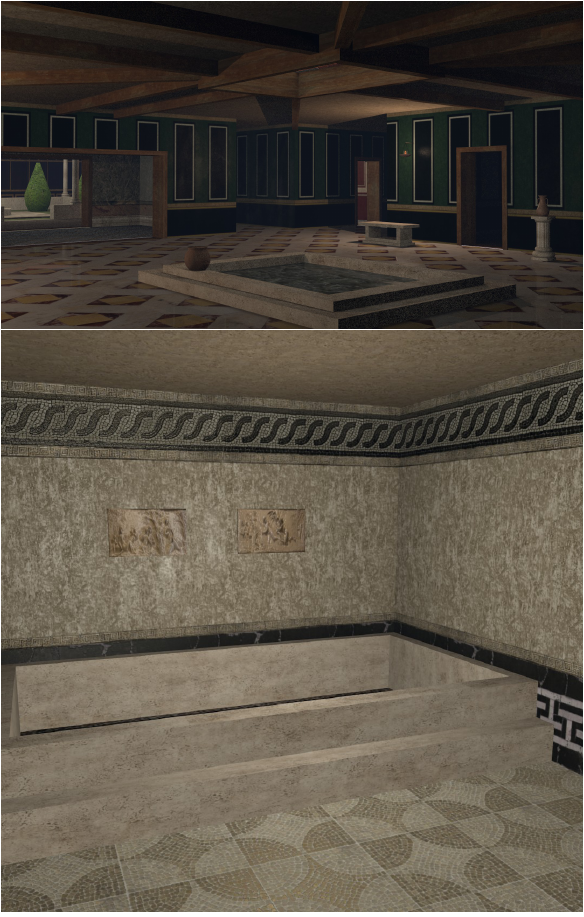
Figure 8: Rendered images of two rooms in the Roman Villa: the atrium (top) and the caldarium , placed over the hypocaustum